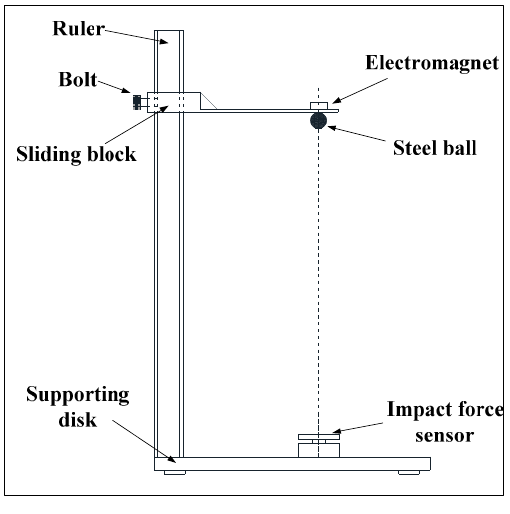
Figure 2. Drop ball tester.